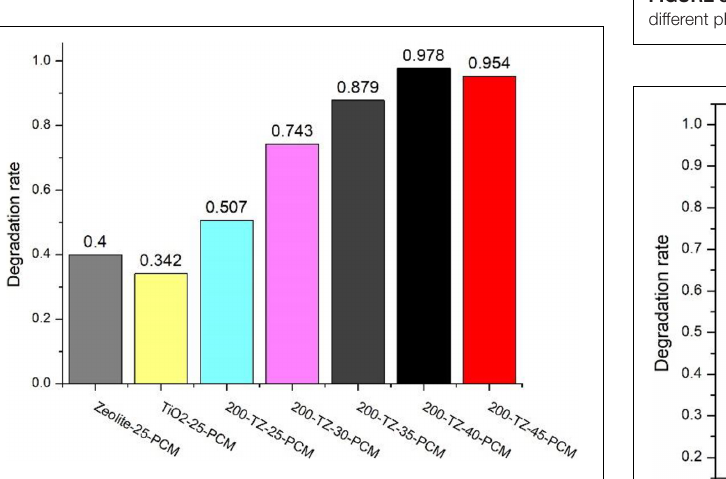
FIGURE 7 | Effect of TiO 2 content on degradation rate.